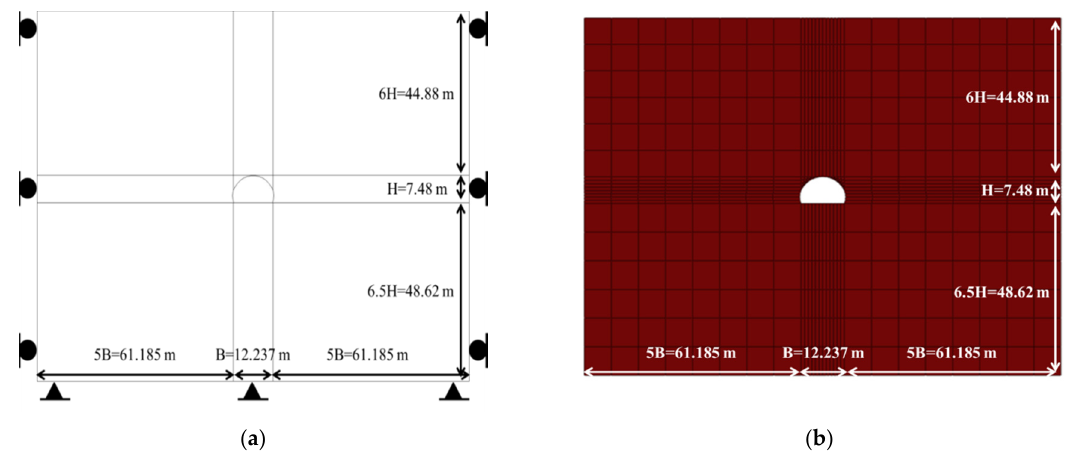
Figure 12. Modeling of analytical ground. ( a ) Schematic diagram and ( b ) mesh formation.